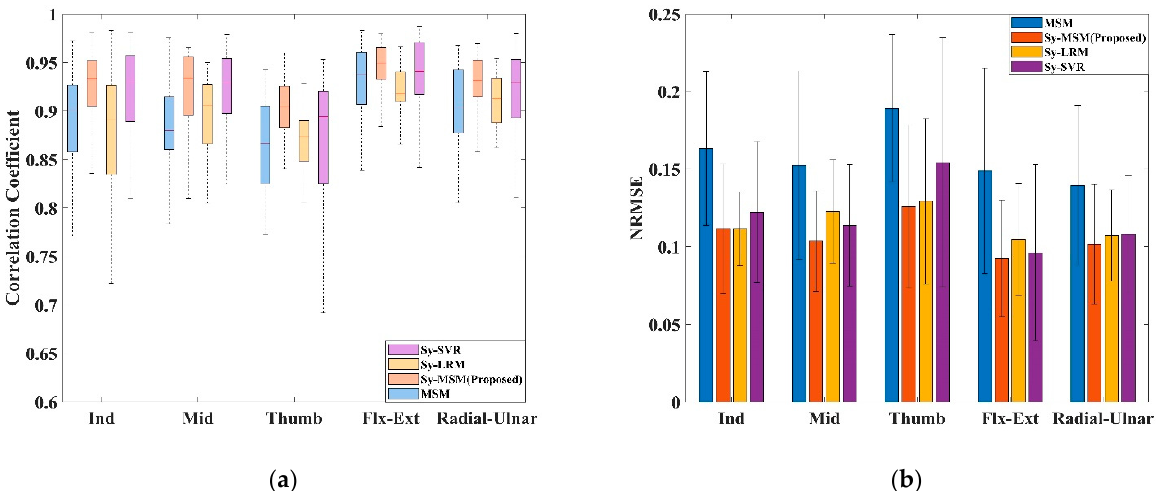
Figure 7. Comparisons of five-fold cross-validation results of all models: ( a ) Average correlative coefficient of the best performance models of all subjects. ( b ) Average NRMSE of the best performance models of all subjects.